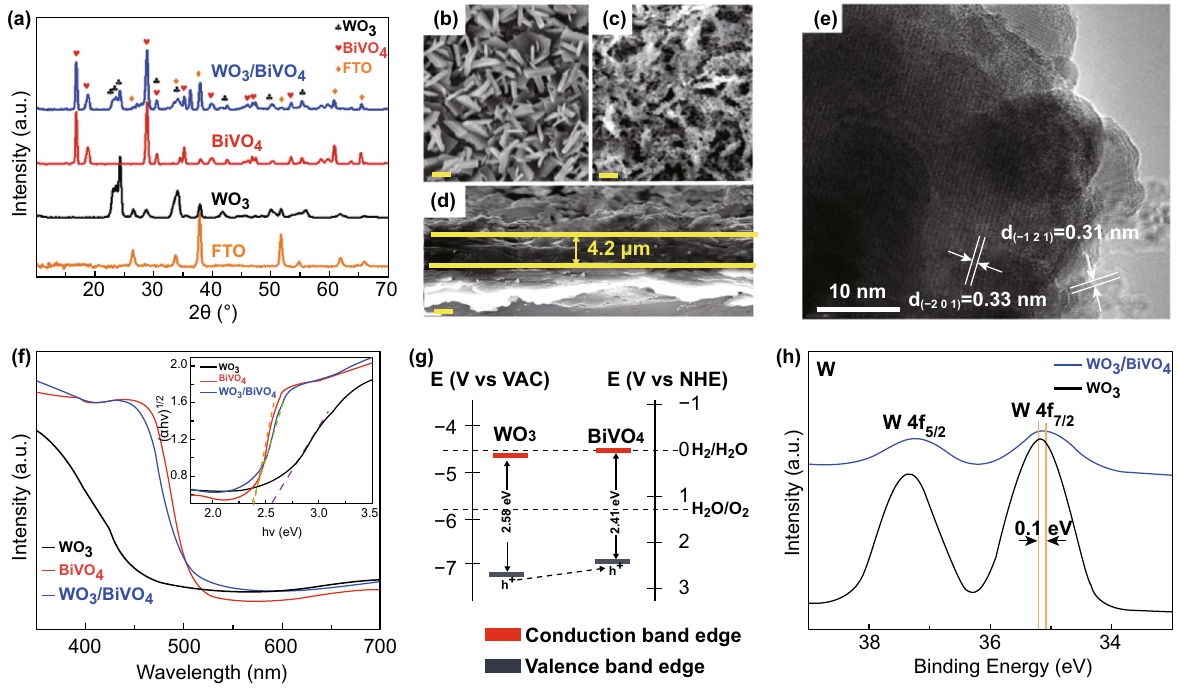
Fig. 1 Characterizations of WO 3 /BiVO 4 heterojunction photoanodes. a XRD spectra of the prepared photoanodes (WO 3 , BiVO 4 , and WO 3 / BiVO 4 ). Top‑view SEM images of b WO 3 , c WO 3 /BiVO 4 , and d cross‑sectional SEM image of WO 3 /BiVO 4 (scale bars, 2 μm). e HRTEM image of WO 3 /BiVO 4 (scale bar, 10 nm). f UV–Vis spectra of the prepared materials. The inset shows Tauc’s plot analysis. g Band structure of WO 3 and BiVO 4 . h High‑resolution XPS curves of photoanodes at the W 4 f